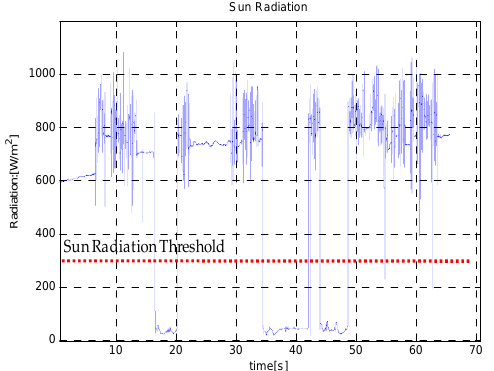
Figure 23. Sun radiation during the long-time dynamic test. Note that below a threshold of 300 W/m 2 , the sensor output is not reliable for absolute heading calculation. Table 7. Statistical comparison of heading estimation algorithms in the dynamic test (only end-trajectory errors are compared). Error (°) Mean Std. Algo.